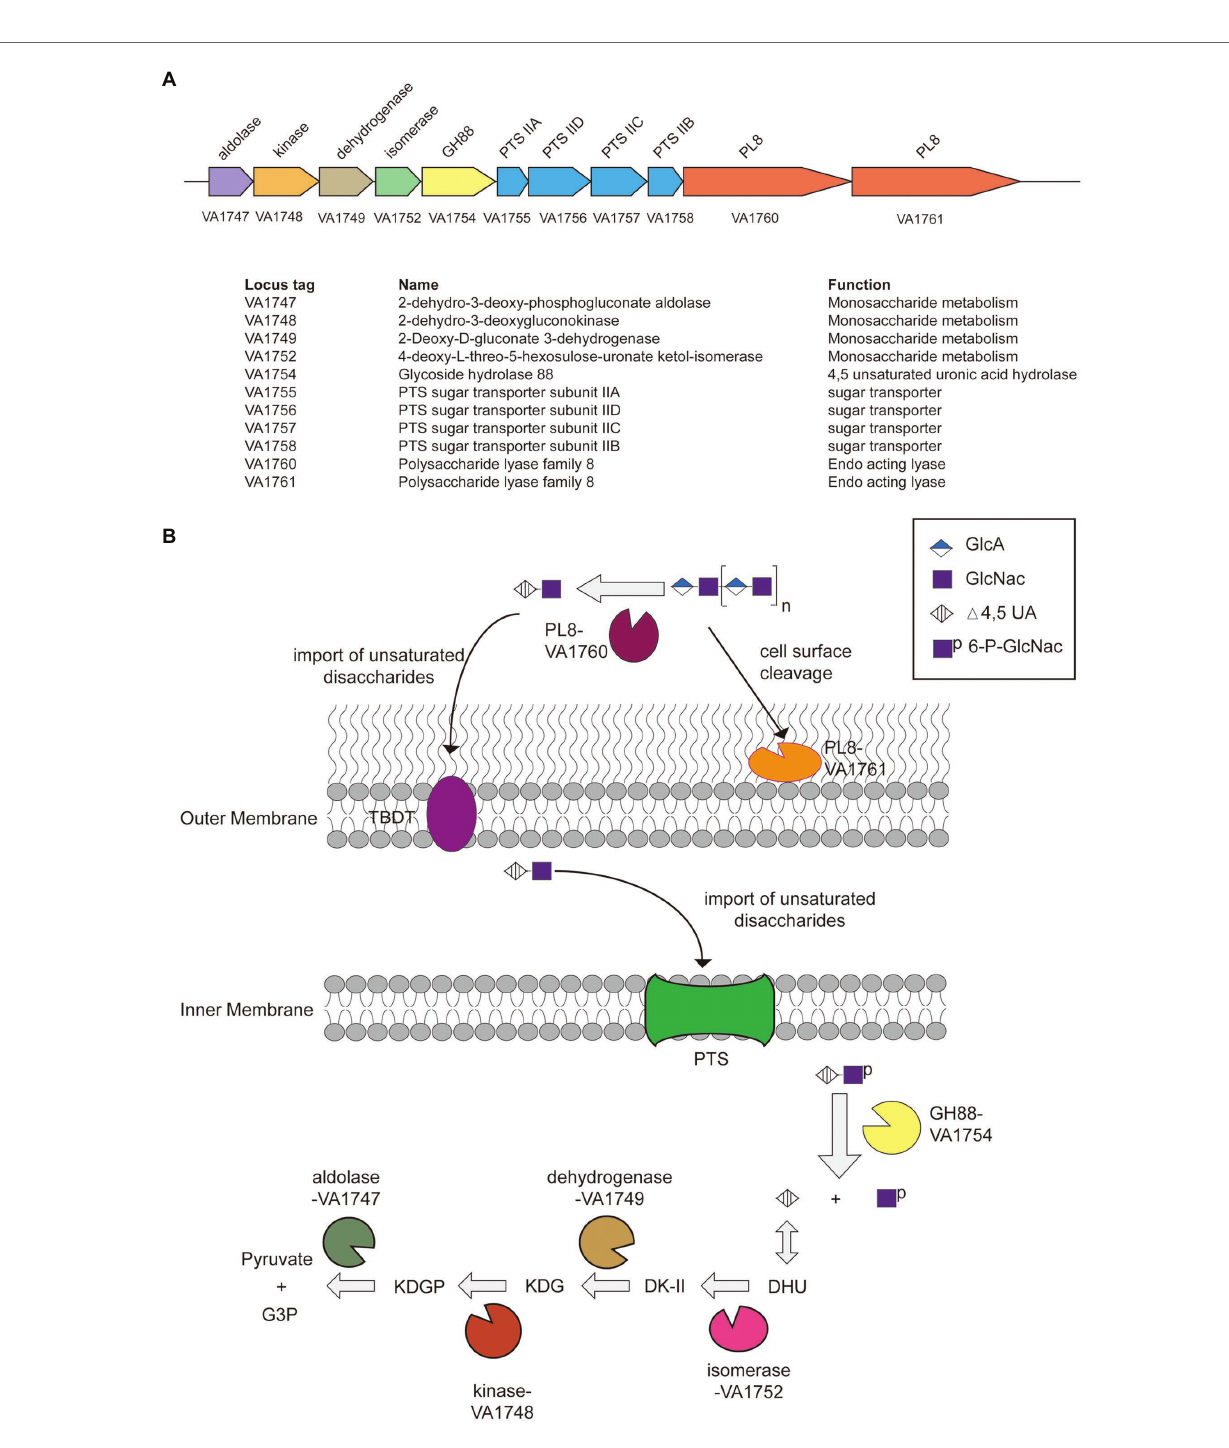
FIGURE 2 | The paradigm of hyaluronic acid (HA) utilization by Vibrio alginolyticus LWW-9. (A) Predicted polysaccharide utilization locus of hyaluronic acid (PUL HA ) in V. alginolyticus LWW-9. (B) Schematic of the cellular location, activity, and specificity of the PUL HA -encoded enzymes. DHU, 4-deoxy-L- threo -5-hexosulose-uronate; DK-II, 3-deoxy-D- glycero -2,5-hexodiulosonate; KDG, 2-keto-3-deoxy-D-gluconate; KDGP, 2-keto-3-deoxy-6-phosphogluconate; and G3P,